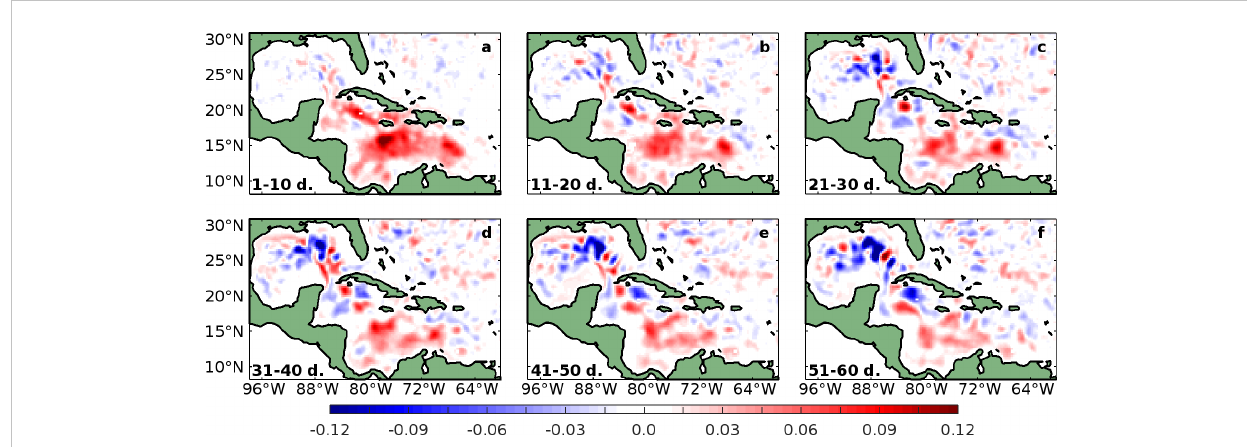
FIGURE 5 Differences in simulated SSH root-mean square errors (in meters) between the forecast cycles initialized from the NoCarib experiment and from the Ref experiment (RMSE NoCarib -RMSE Ref ), averaged for the same forecast periods as in Figures 3, 4. Positive values indicate higher RMSE in the NoCarib experiment.